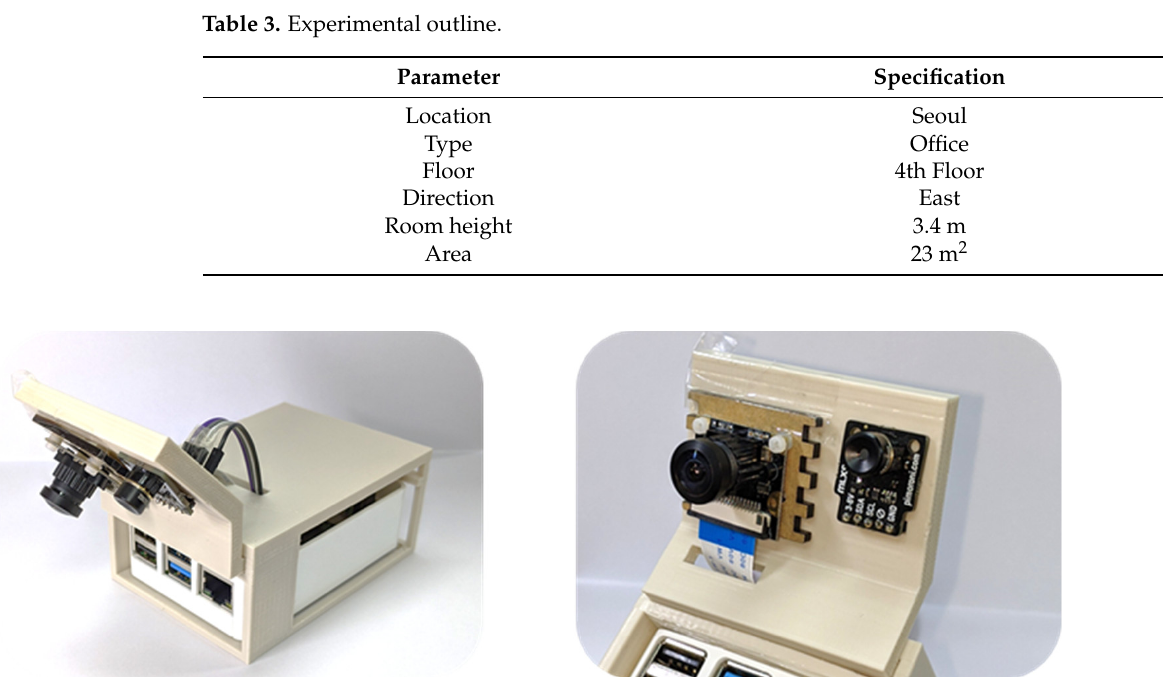
Figure 5. Experimental set-up.